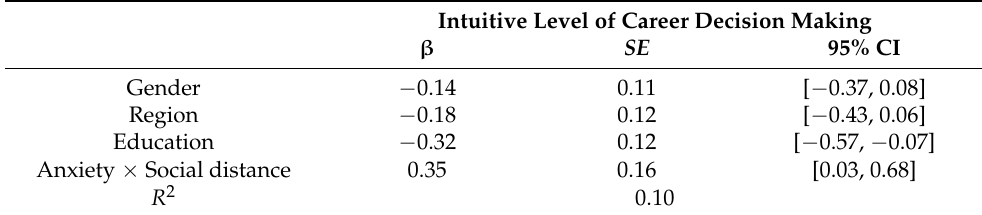
Table 4. Test on the effect of anxiety and social